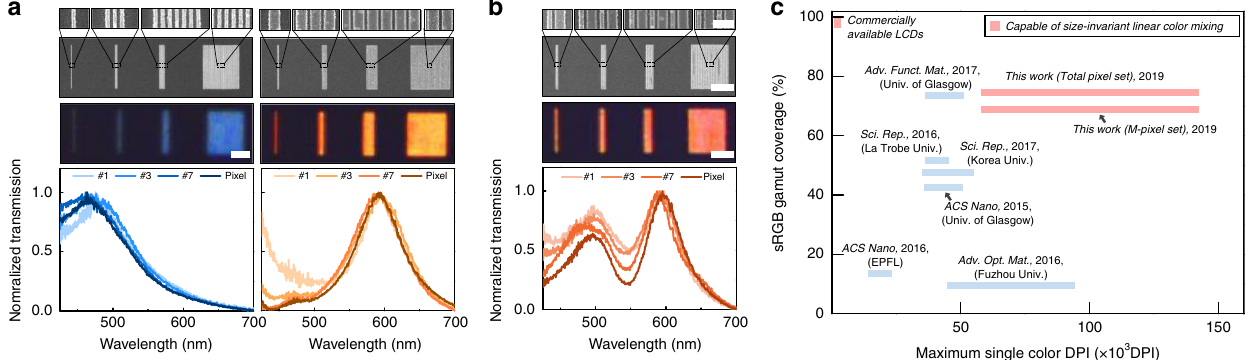
Fig. 3 Ultrahigh resolution color pixels. a Characterization of single color pixels with varying size. Each pixel consists of 1, 3, 7, and more than 20 nanoresonators with widths of 80 nm (left column) and 250 nm (right column), interspaced at 100 nm. b Characterization of dual-color pixels with varying size. Each pixel consists of 1, 2, 3, and more than 20 repeating units of a pair of nanoresonators with widths of 100 and 250nm, interspaced at 100 nm. a , b High-magni fi ed SEM ( fi rst row), low-magni fi ed SEM (second row), OM (third row) and normalized transmission spectra (fourth row) of the four pixels. Scale bar is 500 nm, 5 µ m and 5 µ m, respectively. c Plot of sRGB coverage and single color DPI from a representative collection of reported transmissive color fi lters. Color fi lters that are able to support size-invariant linear color mixing are shown in red. Note that all data points 3,8,14,16,50,51